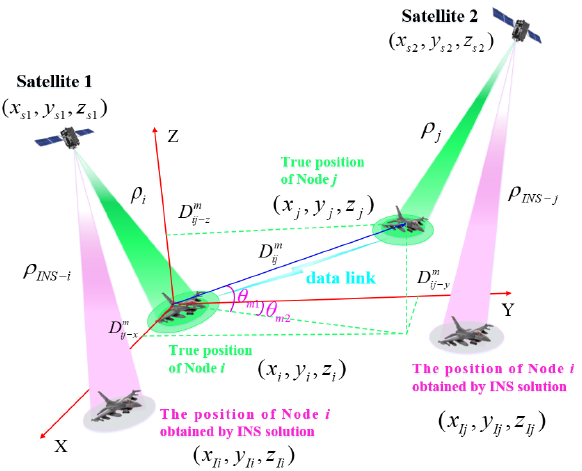
Figure 1. Schematic diagram of node self-positioning process.